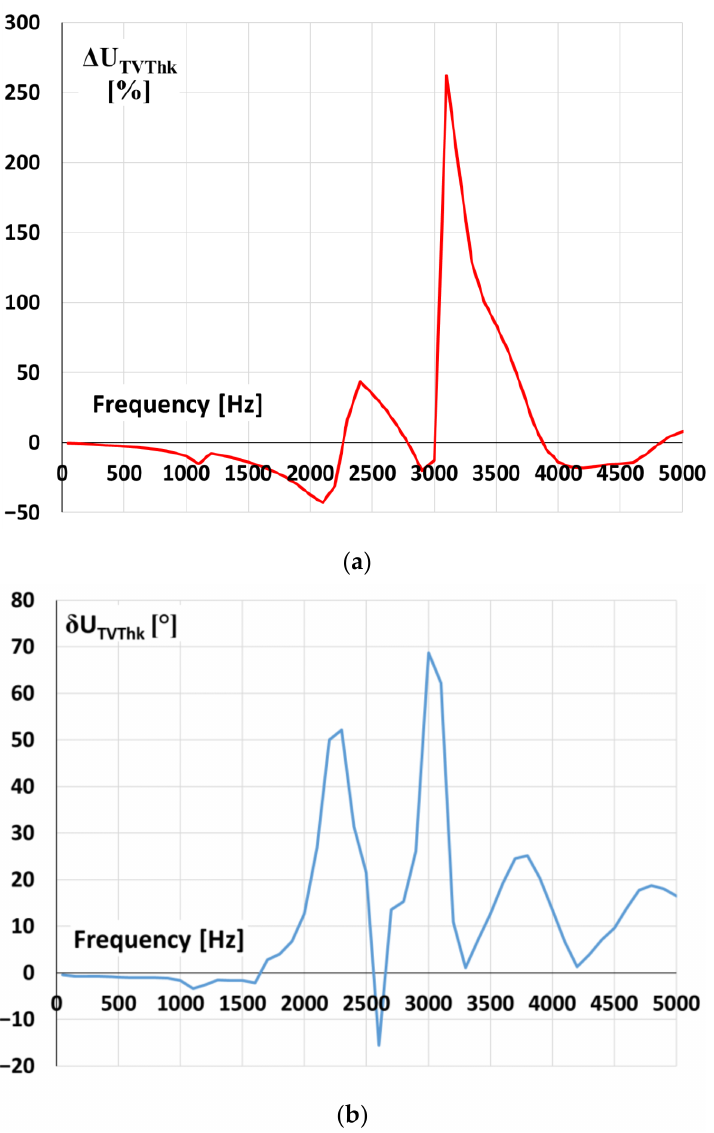
Figure 10. The values of ( a ) voltage error and ( b ) phase displacement at harmonics of the 20 kV voltage transformer (model